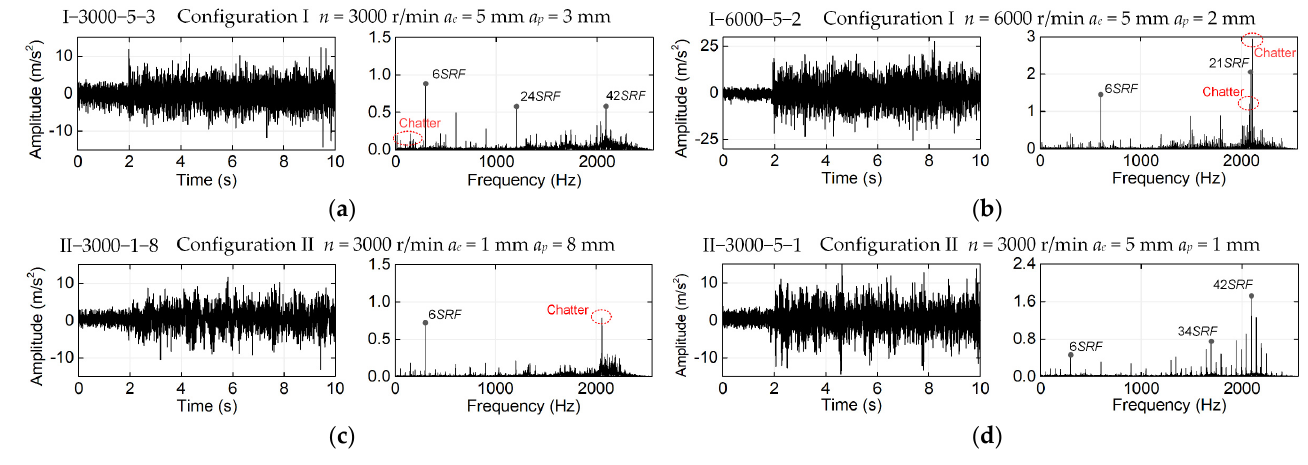
Figure 4. The original vibration signals (left), the FFT results of original vibration signals (right): ( a ) Test No. 7: I − 3000 − 5 − 3; ( b ) Test No. 10: I − 6000 − 5 − 2; ( c ) Test No. 12: II − 3000 − 1 − 8; ( d ) Test No. 14: II − 3000 − 5 − 1.